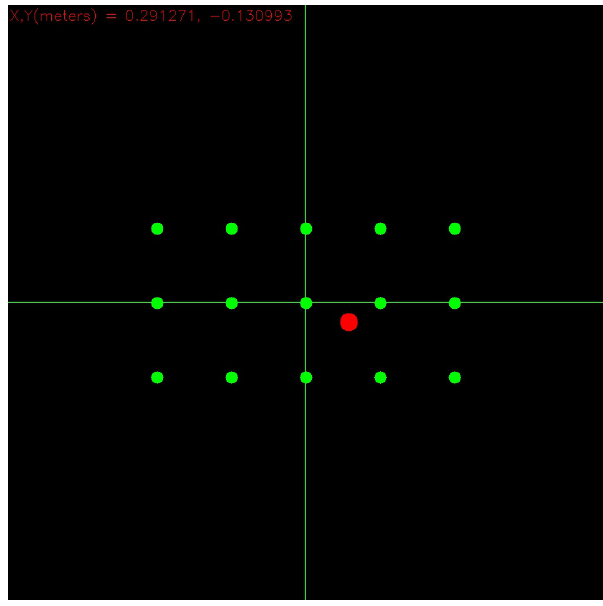
Figure 6. A picture of the monitor where gaze hits can be